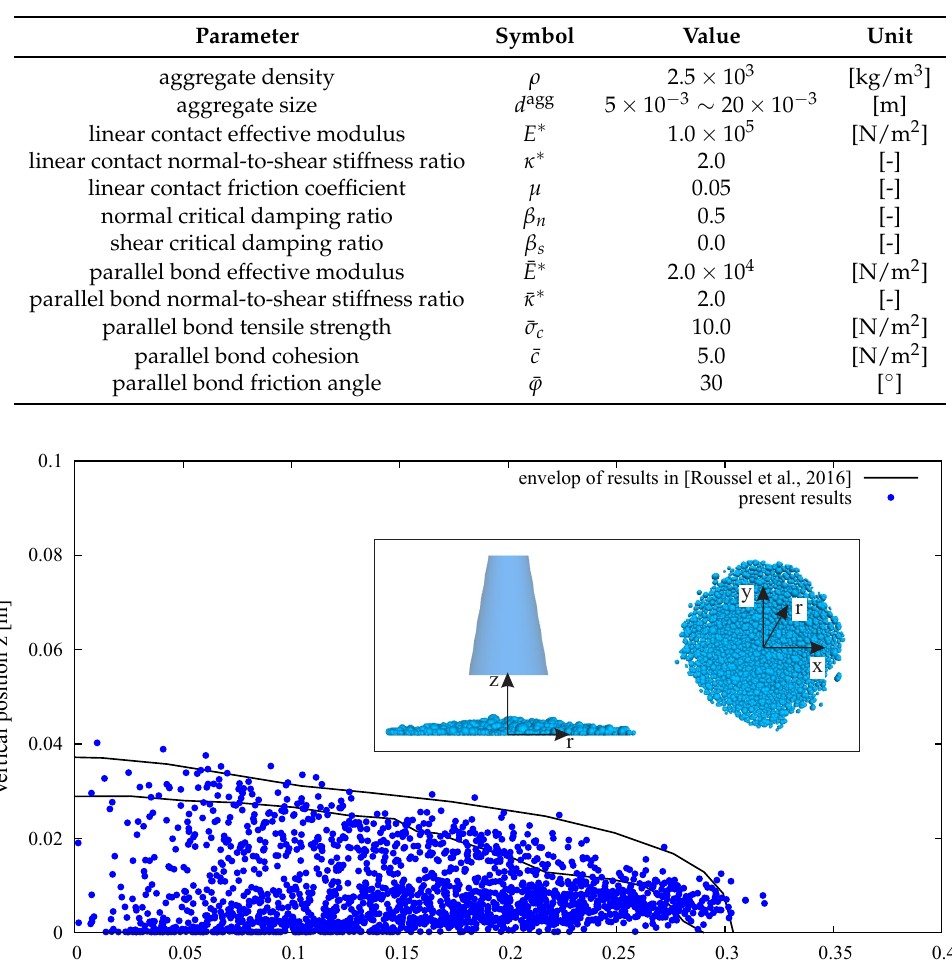
Table 1. Main parameter values considered for the in the present DEM simulation.